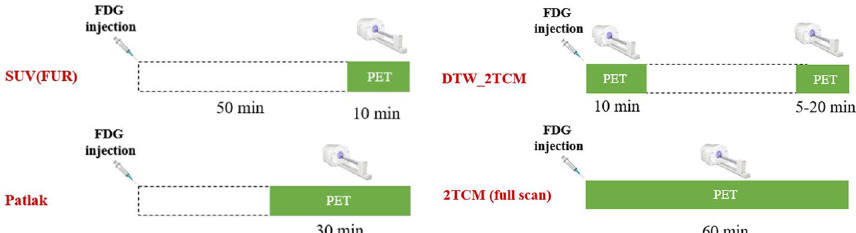
Fig. 1 Scan protocols of different quantification methods used in this